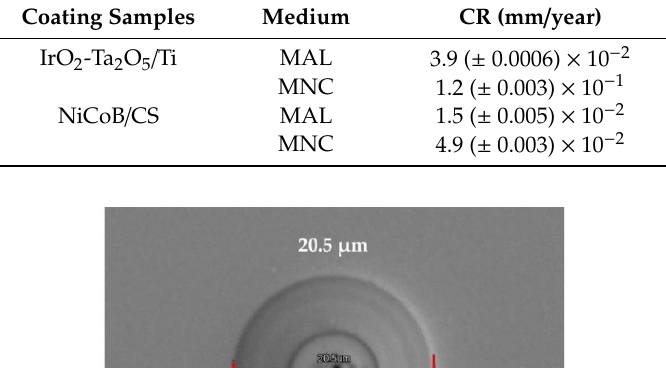
Table 3. Corrosion potential values for the NiCoB/CS and IrO 2 -Ta 2 O 5 /Ti coatings. Coating Samples